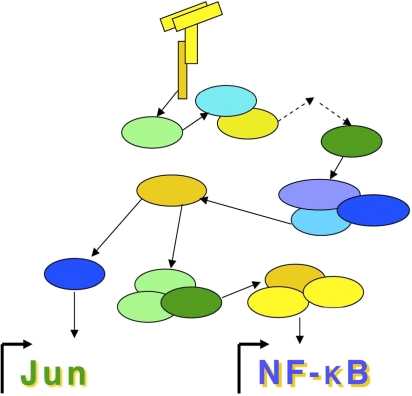
CARMA1 (purple oval), part of a signaling pathway required for regulatory T cell development in the thymus, links T cell receptor ligation to activation of the transcription factors NF-κB and Jun.